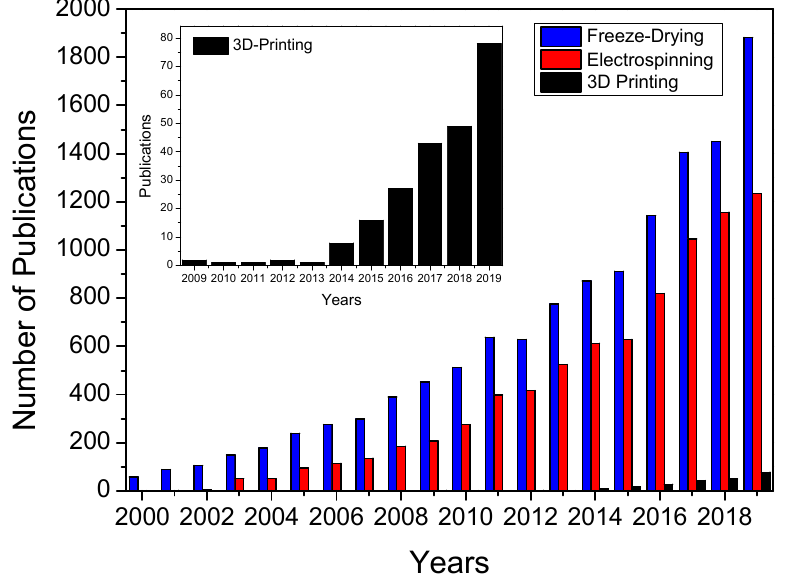
Figure 6. Evolution of the number of publications related to the use of freeze-drying, electrospinning and 3D printing in the biomaterials field. Data obtained from web of science. A magnification of the number of publications concerning 3D printing has also been included.